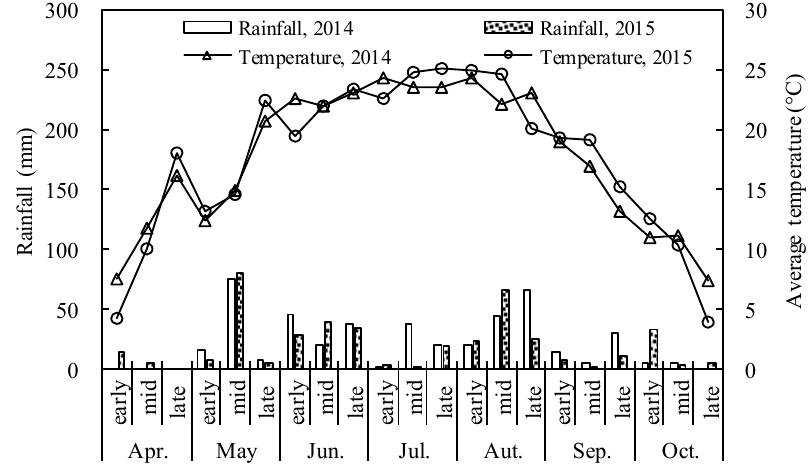
Figure 1. Accumulated rainfall (mm) every 10 days and corresponding average temperature (°C) for the growing season of spring maize in 2014 and 2015 in Lishu County, Jilin Province, China. Four N experiments were conducted in 2014 and 2015 (Table 1). Each experiment used the same maize variety (Liangyu 11), the same plant population of 65,000 plant·ha − 1 , and had the same six N rate treatments (0, 60, 120, 180, 240, and 300 kg·ha − 1 ). The N fertilizers were applied in two split applications: 1/3 as basal application before planting, and the remaining 2/3 as side-dressing at the V8 growth stage. Sufficient phosphate (90 kg P 2 O 5 ·ha − 1 ) and potash (100 kg K 2 O·ha − 1 ) fertilizers were applied before planting to make sure phosphorus (P) and potassium (K) nutrients were not